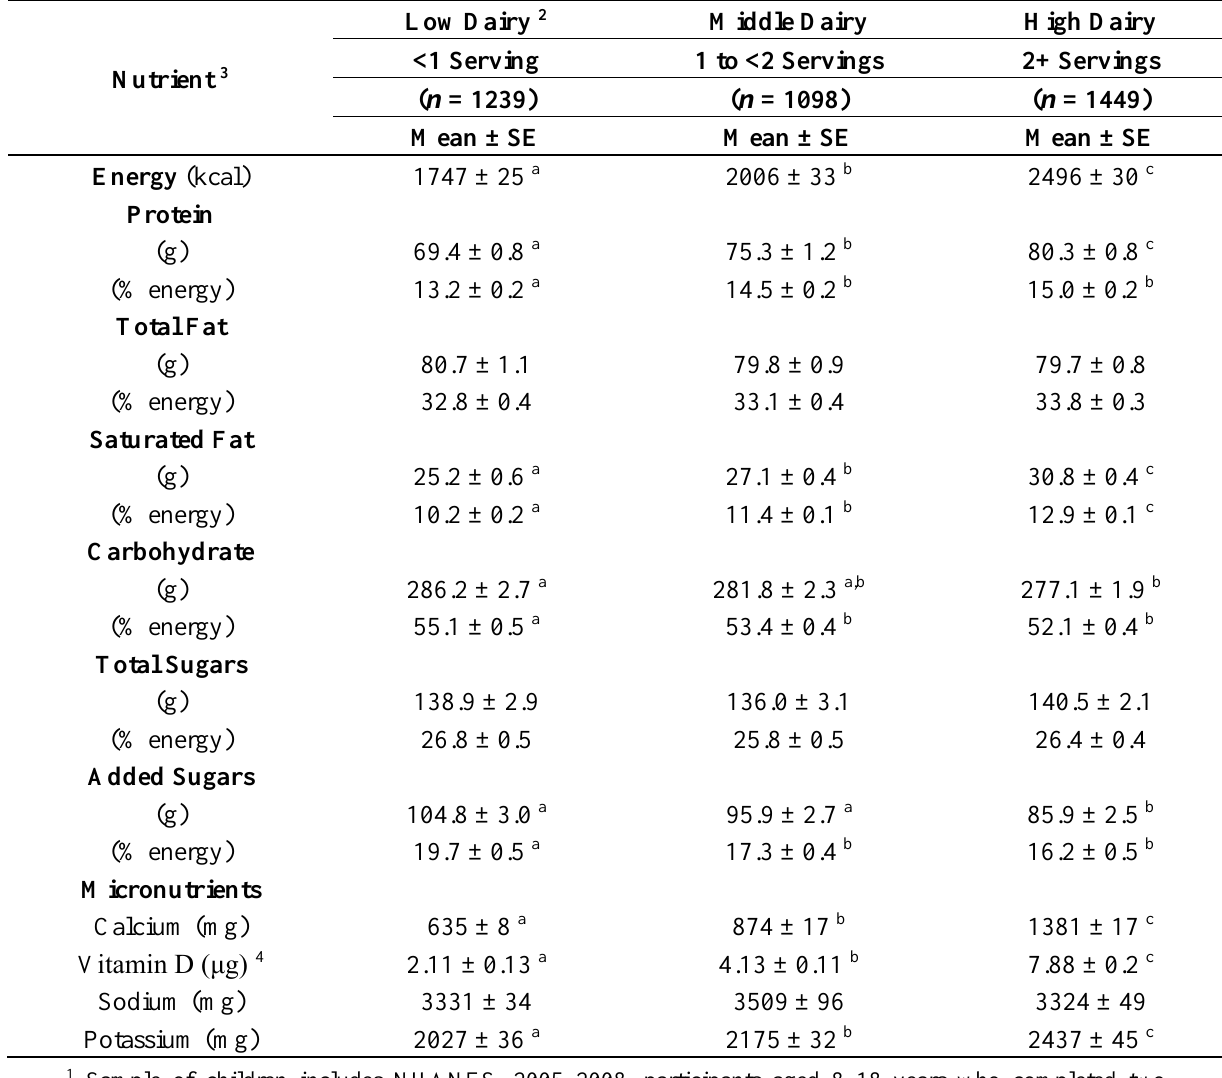
Table 2. Covariate-adjusted mean energy, macronutrient, calcium, vitamin D, sodium, potassium intake by dairy consumption groups 1